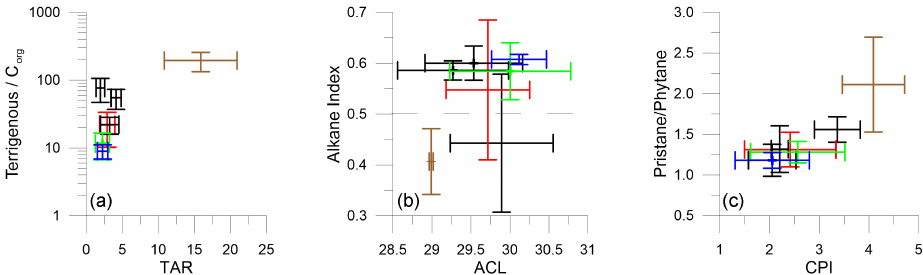
Figure 5. Scatter plot of average ± standard deviation of (a) TI versus TAR, (b) AI versus ACL, and (c) Pr / Ph versus CPI. Colours refer to samples from the coast and inner shelf (brown), outer shelf and upper slope (black), relict outer shelf sediment (orange), upper slope – SACW (green), middle slope – IWBC (red) and middle slope – DWBC (blue). values around 4.4 µg gC − 1 . Considering this last index, there is a dilution of about 16 times of C 27 − 29 − 31 per gC, from the inner shelf to the middle